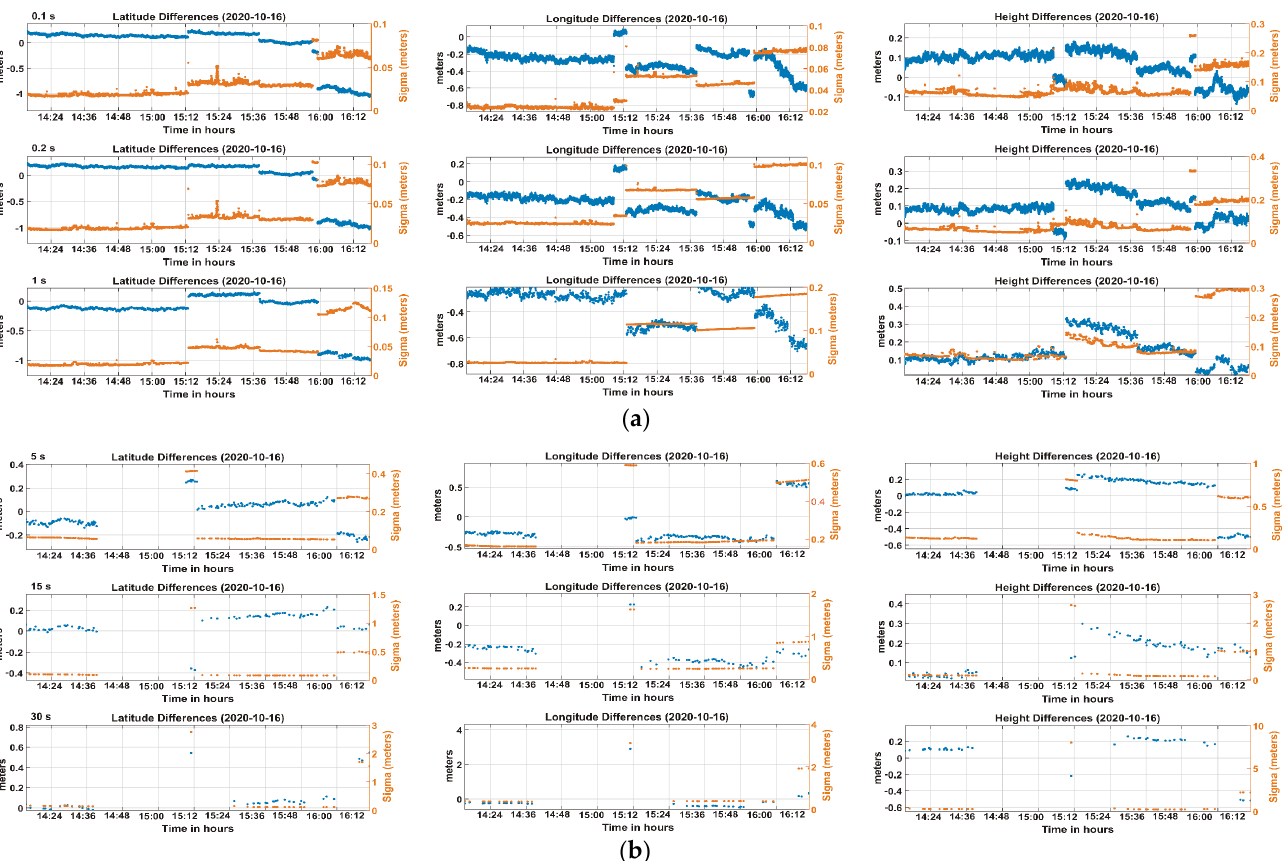
Figure 14. Low-cost GNSS static mode obtained by processing with CSRS-PPP: ( a ) sampling rate: 0.1, 0.2 and 1 s; ( b ) sampling rate: 5, 15 and 30 s.